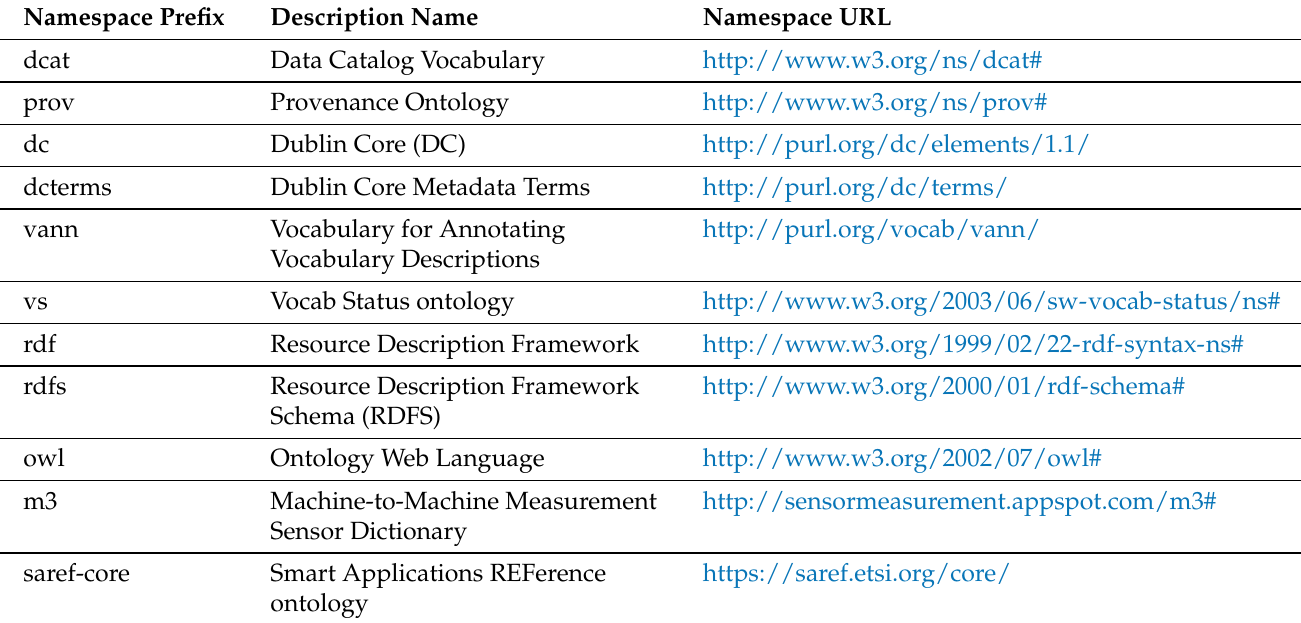
Table 4 reminds of the namespaces used: the first column for the prefix name, the second column for the namespace description, and the third column for the ontology namespace URL. Table 4. Ontology Namespace. URLs accessed on 17 September